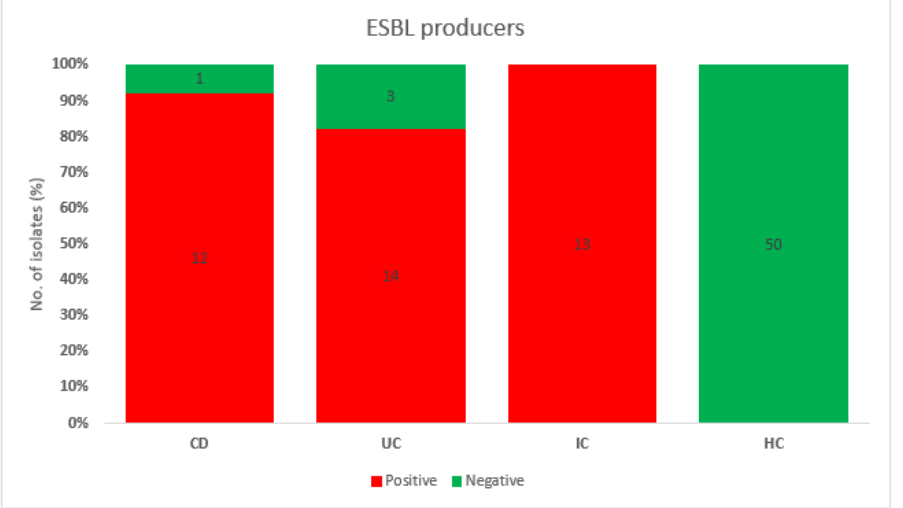
Figure 6. ESBL producing isolates from patients with CD, UC, and IC and the HC